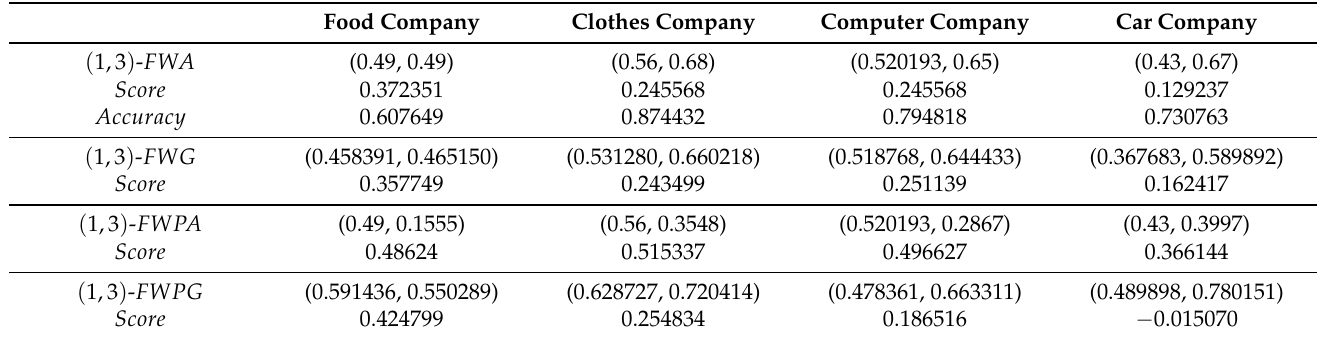
Table 2. Evaluation of scores with ( 1,3 ) -Fuzzy aggregation